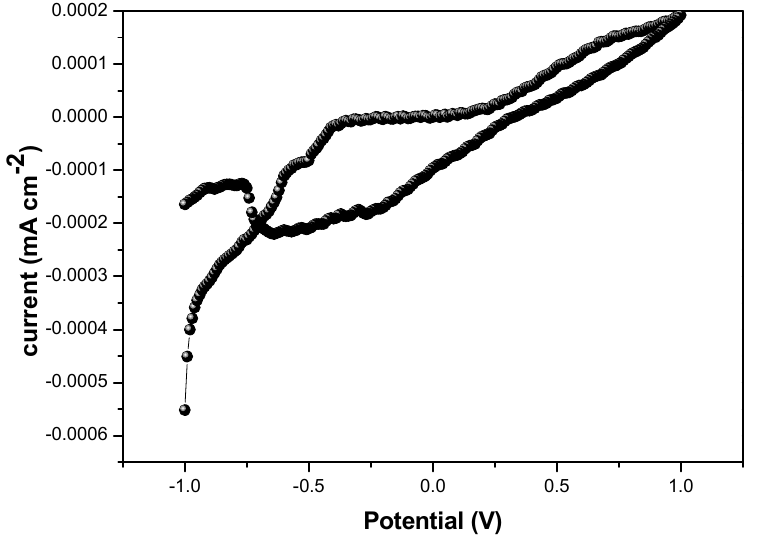
Figure 6. The cyclic J (E) voltammetry of ZnBi 2 O 4 plotted in NaOH (0.1 M) with a scan rate of 10 mV s − 1 .